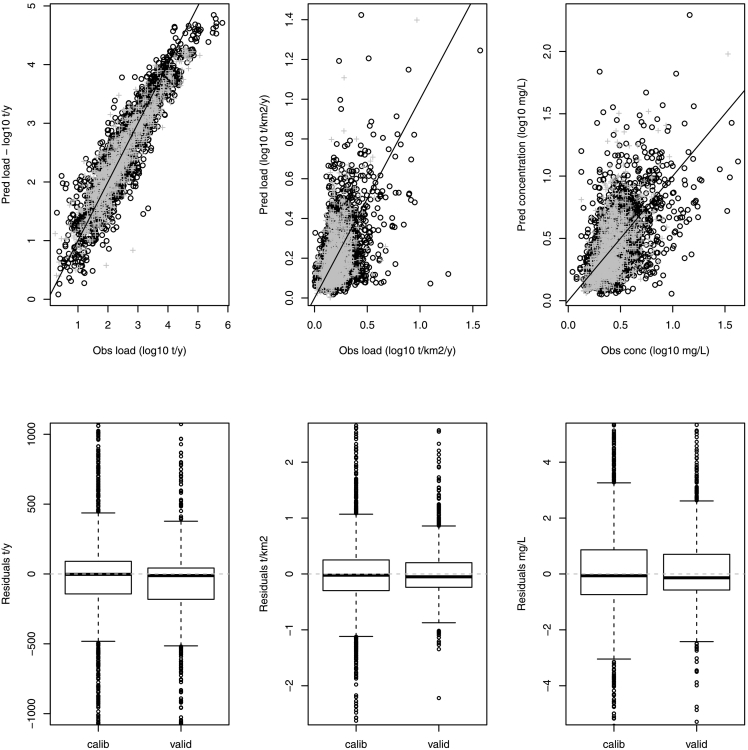
Above: modelled (y axis) vs observed (x axis) BOD fluxes (in logarithmic scale), from left to right: mean annual load (t/y); specific loads (t/km2/y); and concentrations (mg O2/L). Calibration dataset is indicated with black circles and validation dataset in grey crosses. Below: boxplots of modelled flux residuals (normal scale) for calibration and validation datasets.